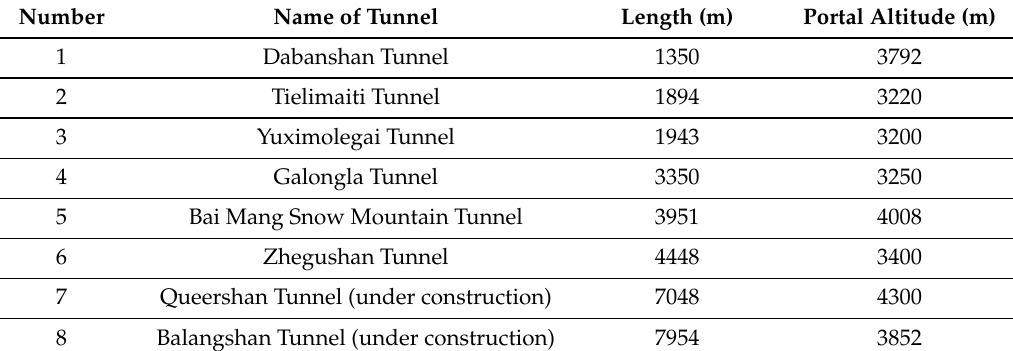
Table 1. Statistics of completed and under-construction high-altitude tunnels in China.